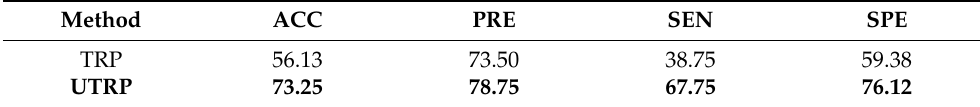
Table 4. AF detection performance based on RP by means of the